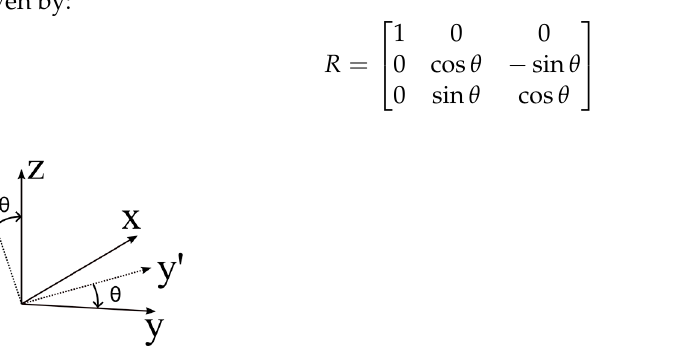
Figure 6. The transformation from the contact patch frame to the orthogonal reference frame.